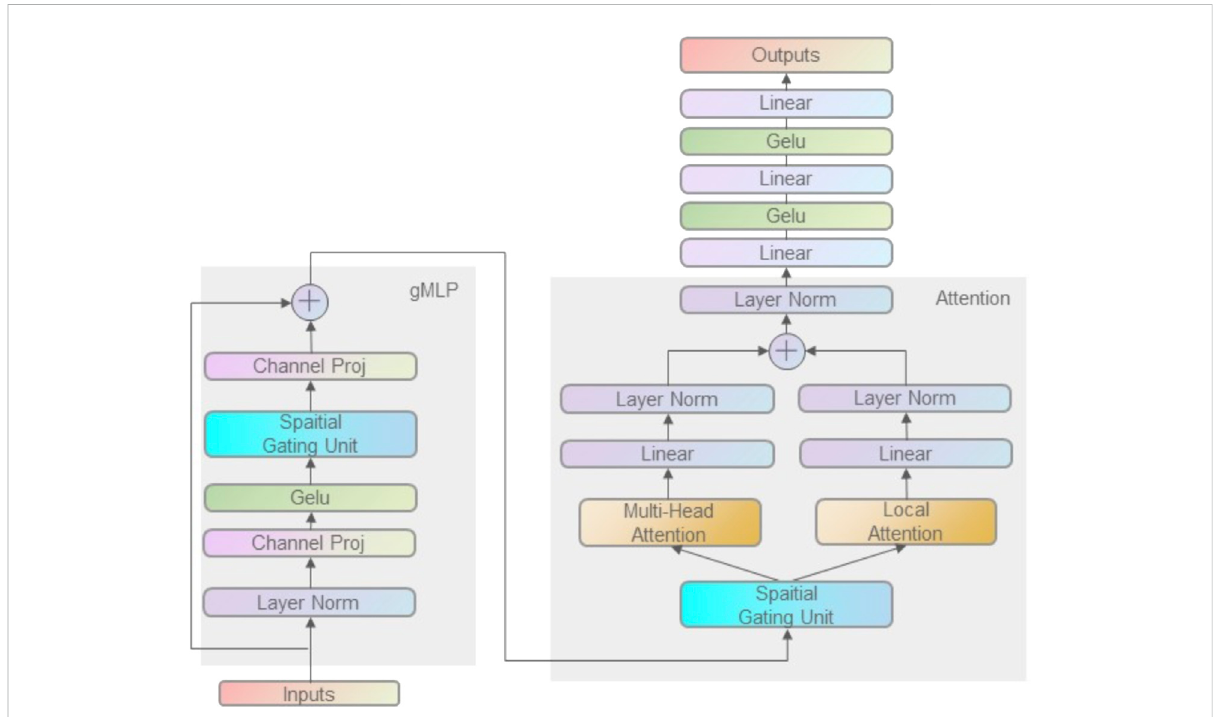
FIGURE 1 gMLP model framework with attention mechanism. The TCR CDR3 sequences and peptide sequences were encoded by BLOSUM50 matrix as model input. Firstly, the spatial information was obtained by gMLP, and then Multi-head Attention and Local-Attention were used to extract the correlationinformationofTCRCDR3andpeptide sequences. Finally,theoutputofisobtained byinterleavingfully connectedlayers andGelulayers.